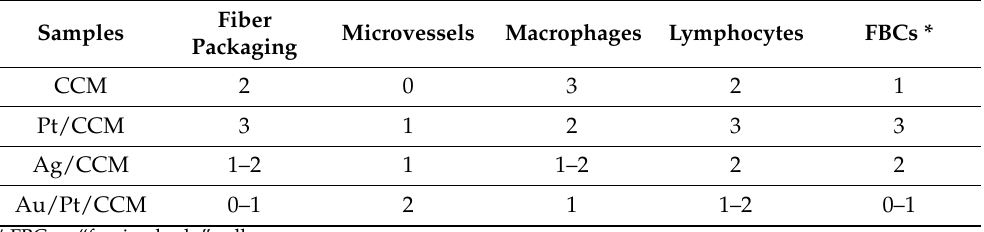
Table 3. Scoring of histological features of pristine and coated СС M samples after subcutaneous implantation in rats for 1 month.